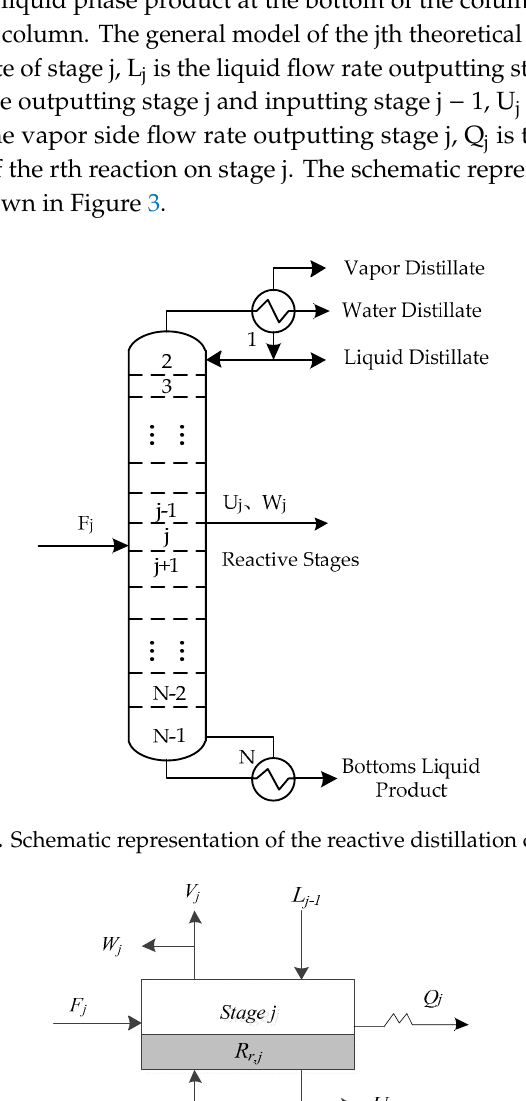
Figure 2. The jth equilibrium stage of the reactive distillation column.